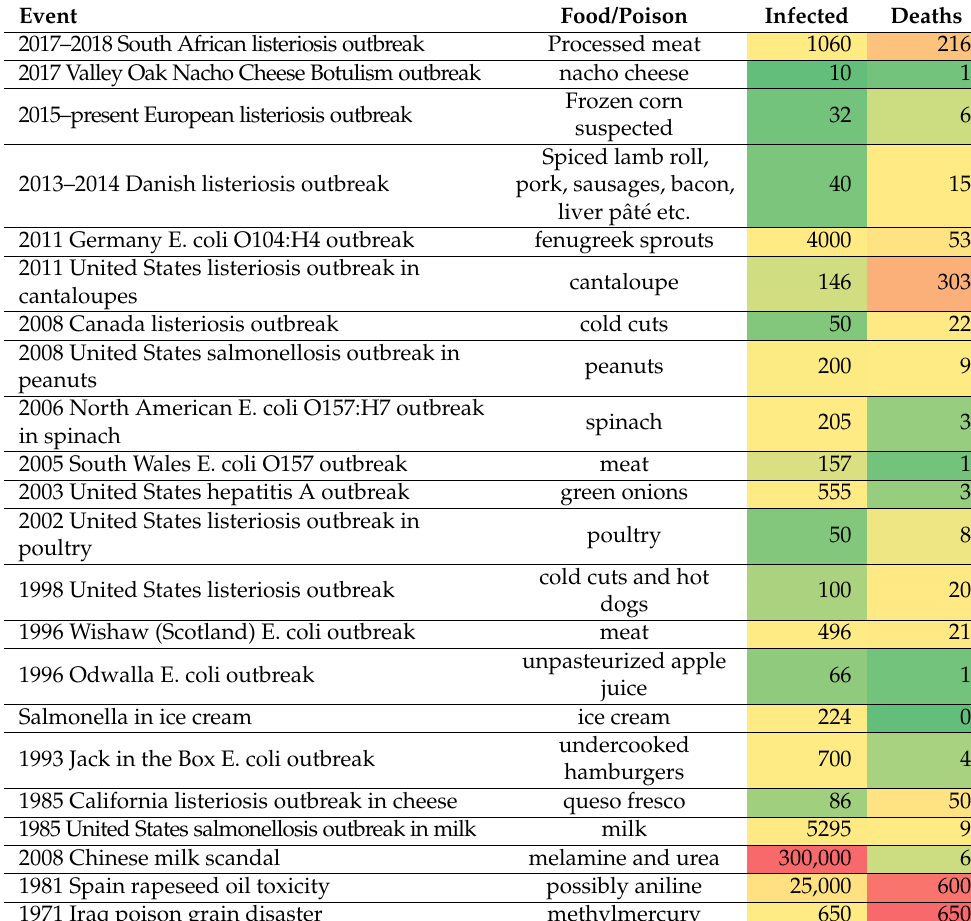
Table 1. Worse foodborne events.